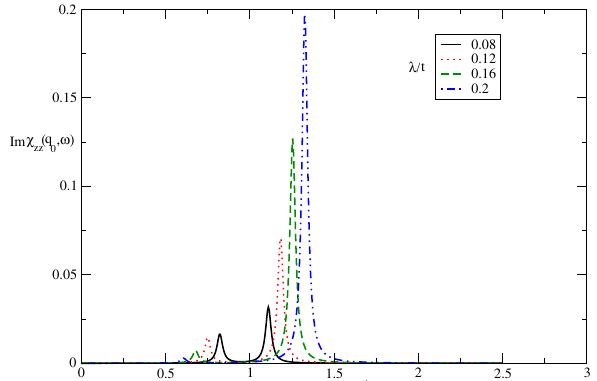
Figure 3. The imaginary part of dynamical longitudinal spin susceptibility Im χ zz ( q 0 , ω) of undoped Germanene layer versus normalized frequency ω/ t for different values of normalized spin-orbit coupling (cid:31) / t at 0.05 . The magnetic field is considered to be fixed temperature k B T / t =